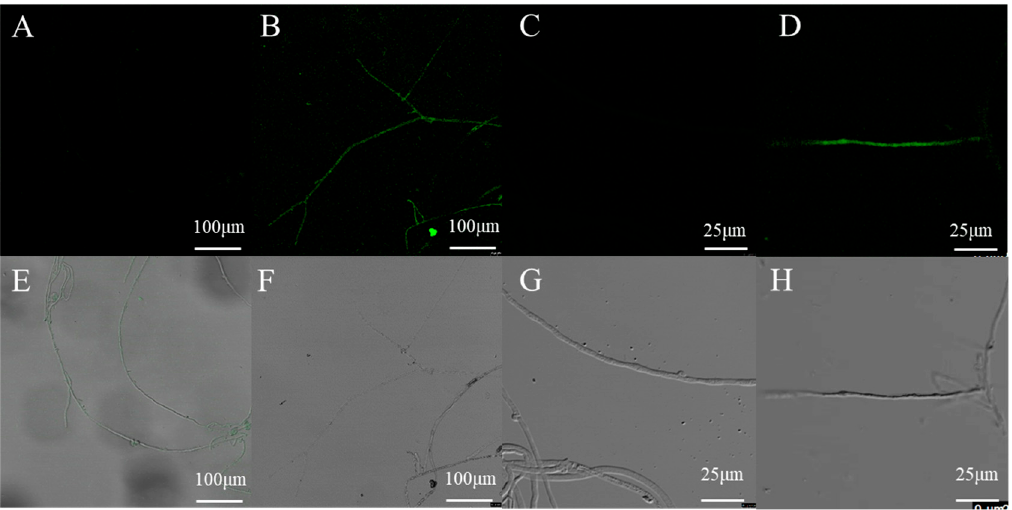
Figure 7. Confocal microscopy analysis of randomly selected transformants harboring eGFP . ( B , D , F , H ) the mycelia of one randomly selected transformant harboring eGFP ; ( A , C , E , G ) the mycelia of untransformed L. edodes strain W1 .